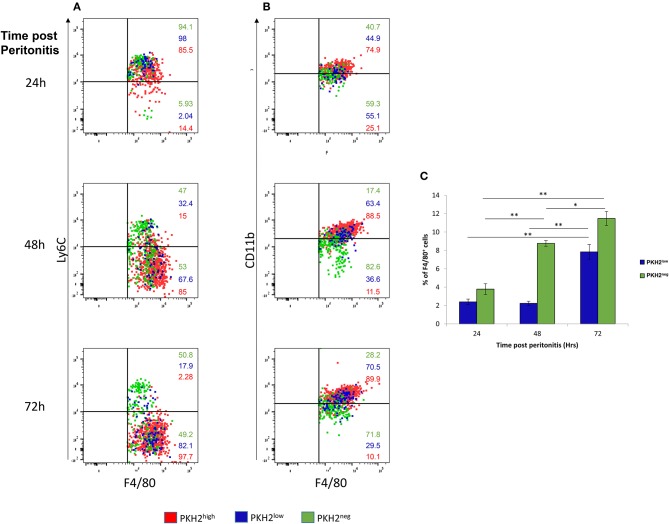
Non-phagocytic monocytes and satiated macrophages show different kinetics during the resolution of peritonitis. (A,B) Dot plots of F4/80+ PKH2-PCL high (red), low (blue), and negative (green) cells are presented relative to Ly6C (A) or CD11b (B). (C) Percentage of F4/80+PKH2low and PKH2negcells at 24–72 h PPI. Results are means ± SEM (n = 8 mice for 24 h, six mice for 48 h, and seven mice for 72 h). *P < 0.05, **P < 0.05 (Tukey's HSD).